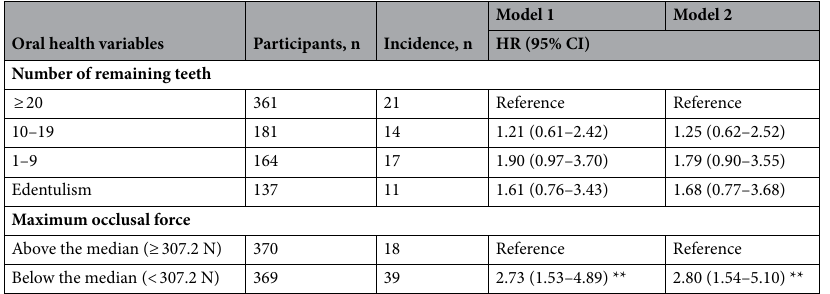
Table 2. Relationships between oral health and the incidence of gastrointestinal cancer. Model 1: adjusted for age and sex. Model 2: adjusted for age, sex, medical history (stroke, diabetes, hypertension, and dyslipidemia), smoking, alcohol drinking, educational level, and physical function. The analyses of number of remaining teeth and maximum occlusal force were conducted separately. HR hazard ratio, CI confidence interval. * P < 0.05; ** P < 0.01.